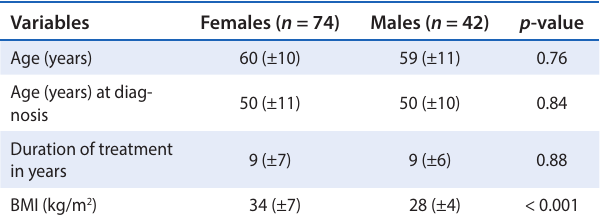
Table 2: Age, age at diagnosis, duration of treatment year and body mass index (BMI) of the 116 patients monitored by glycated haemoglobin (HbA1c) levels (all data are mean ± SD) Variables